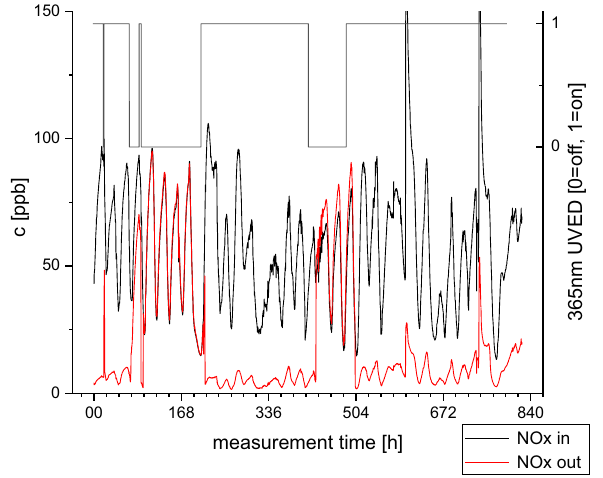
Fig. 1 PMMA reactor measurements for NO the sensitivity of the input meter was observed over the duration of the long-term test. Since this experiment was not repeatable and the deviation caused an underestimation of the reaction capacities, it was nevertheless taken into consideration